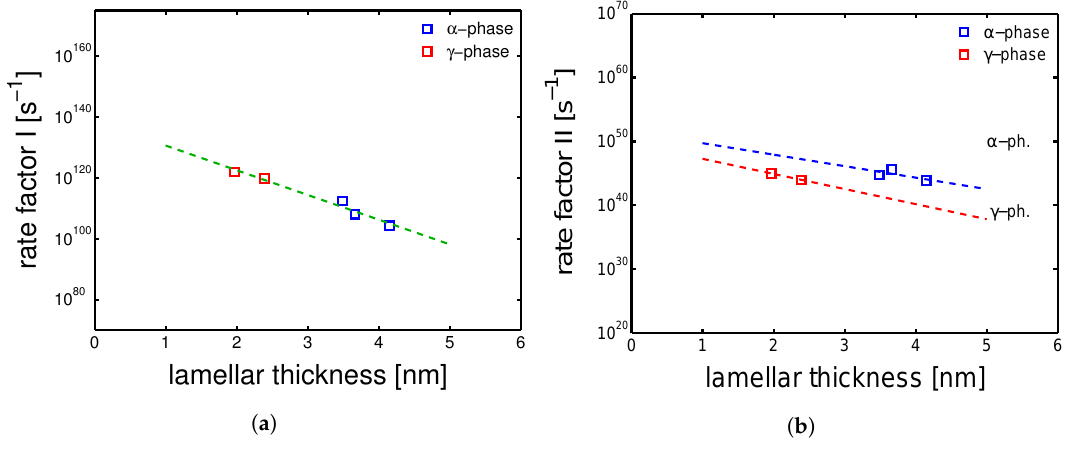
Figure 21. ( a ) rate factor I and ( b ) rate factor II as functions of lamellar thickness. Lines are guides to the